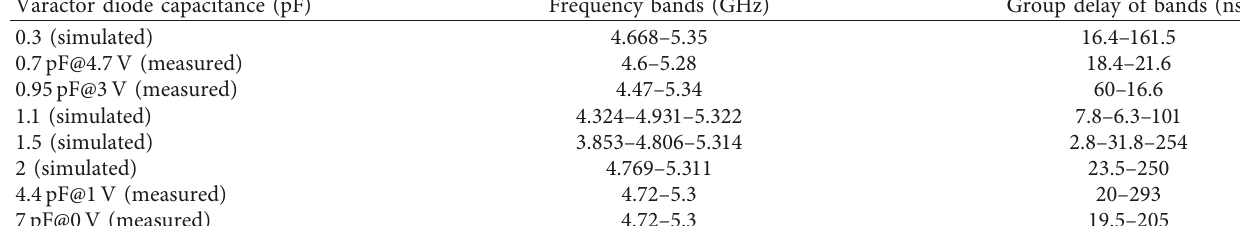
Table 2: Frequency bands and group delay variations of the second proposed resonator for various values of varactor diode capacitance. Varactor diode capacitance (pF)